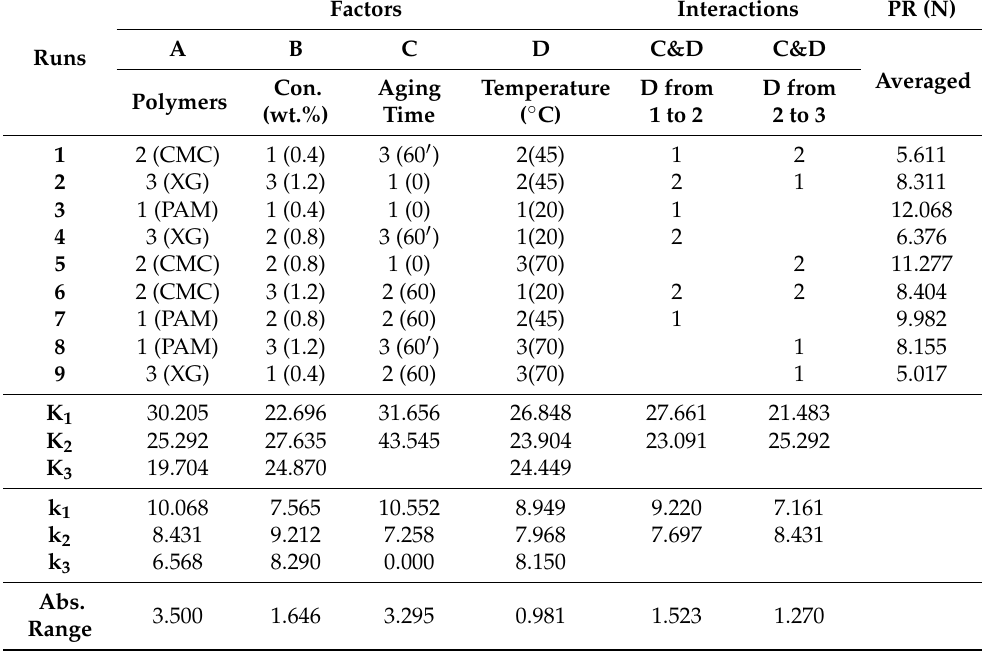
Table 6. Results of temperature aging test for individual polymer application.